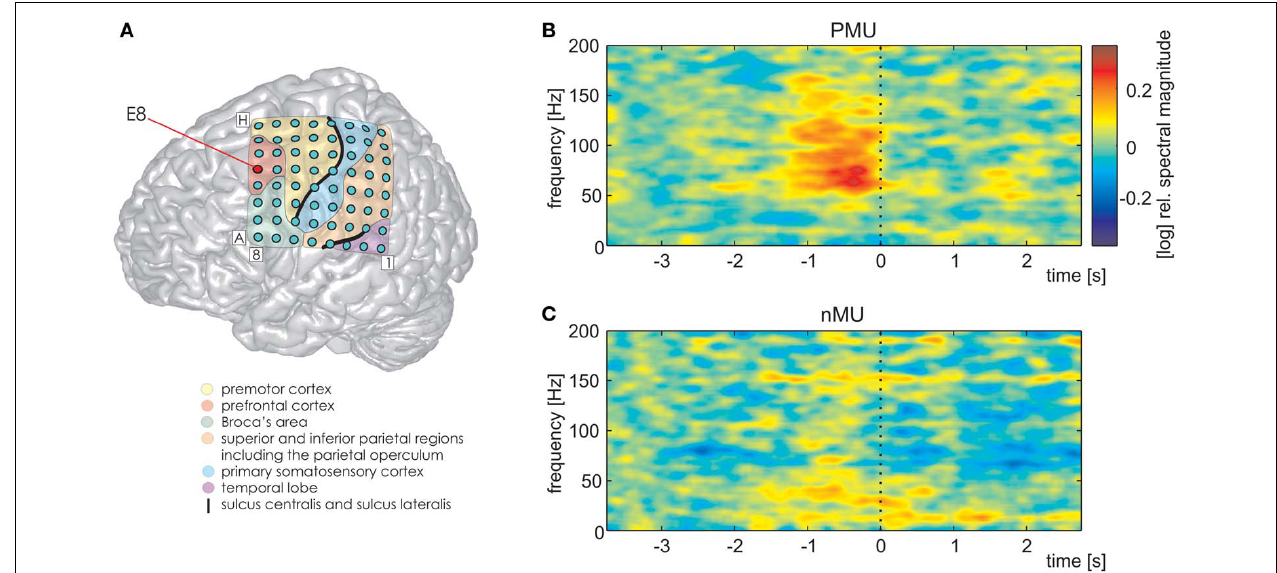
FIGURE 7 | Differential PMU- and nMU-related responses in the left prefrontal cortex of S1. Red circle in (A) marks the prefrontal electrode with significant differences (Wilcoxon rank sum test, FDR-corrected at q < 0 . 01) between the two categories. (B)